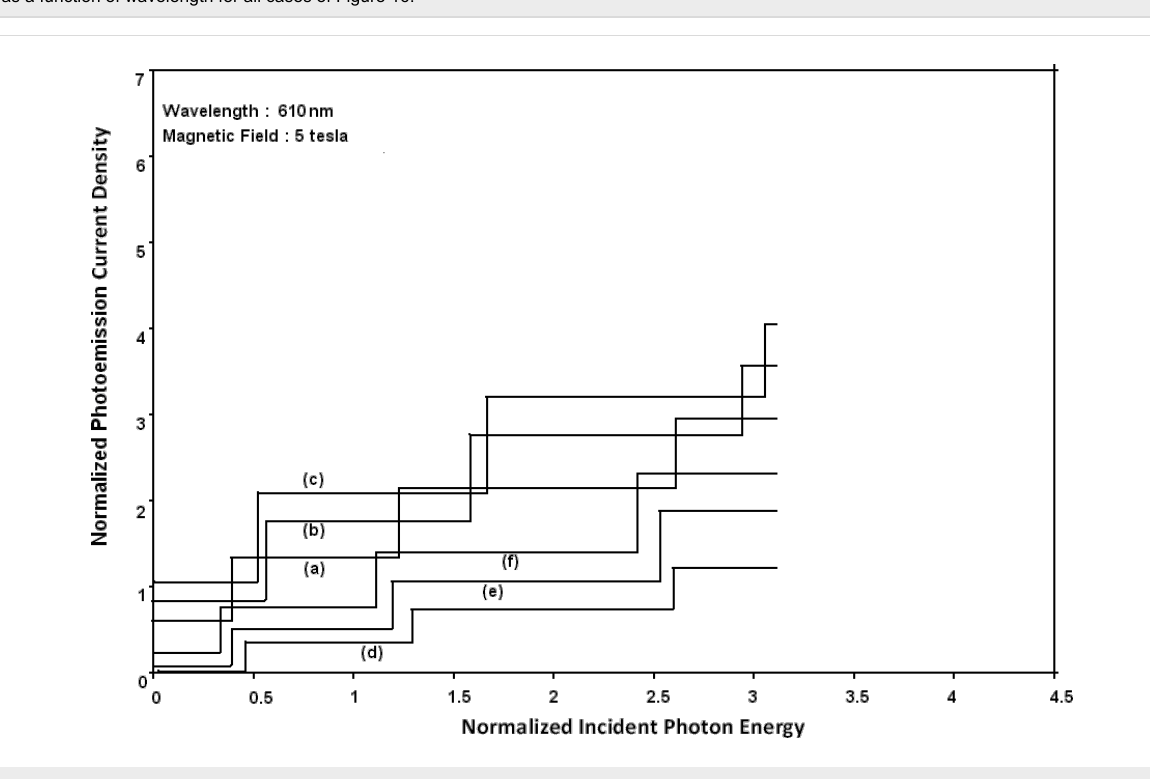
Figure 20: Plot of the normalized magneto photo-emitted current density from effective mass superlattices of HgTe/Hg 1 − x Cd x Te and In x Ga 1 − x As/InP as a function of normalized incident photon energy for all cases of Figure